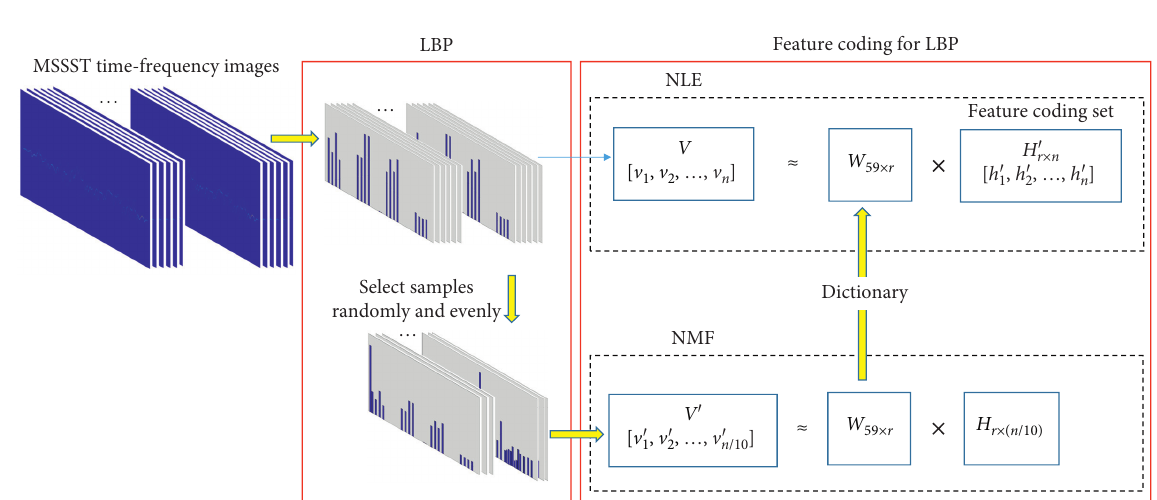
Figure 2: The procedures of